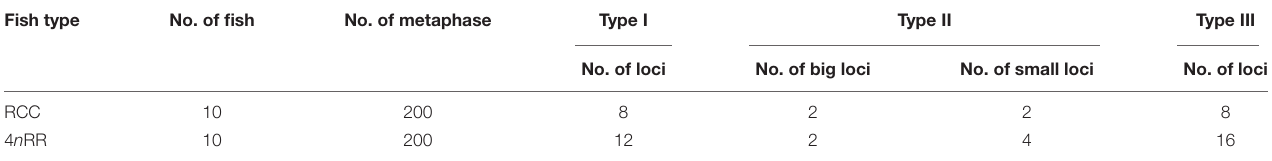
FIGURE 6 | Examination of hybridizing signals by FISH in RCC and 4 n RR. (A) Type I as probe showed eight 5S gene loci (white arrows) in RCC; (B) Type I as probe showed twelve 5S gene loci of type I (white arrows) in 4 n RR; (C) Type II as probe showed two big (yellow arrows) and two small 5S gene loci (white arrows) in RCC; (D) Type II as probe showed two big (yellow arrows) and four small 5S gene loci (white arrows) in 4 n RR; (E) Type III as probe showed eight 5S gene loci (white arrows) in RCC; (F) Type III as probe sixteen 5S gene loci (white arrows) in 4 n RR. Bar = 3 µ m. TABLE 2 | Examination of chromosome locus numbers in RCC and 4 n